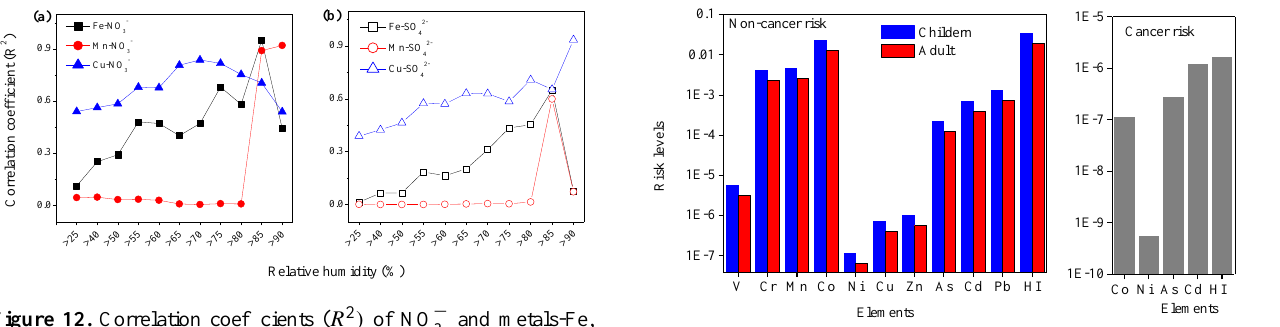
Figure 12. Correlation coefficients ( R 2 ) of NO − Mn and Cu under certain relative humidity bins (a) ; correlation co- efficients of SO 2 − and metals-Fe, Mn and Cu under certain relative 4 humidity bins (b) . For each time of calculating the R 2 , the data of NO − or SO 2 − and each metal were used for corresponding relative 3 4 humidity bins.